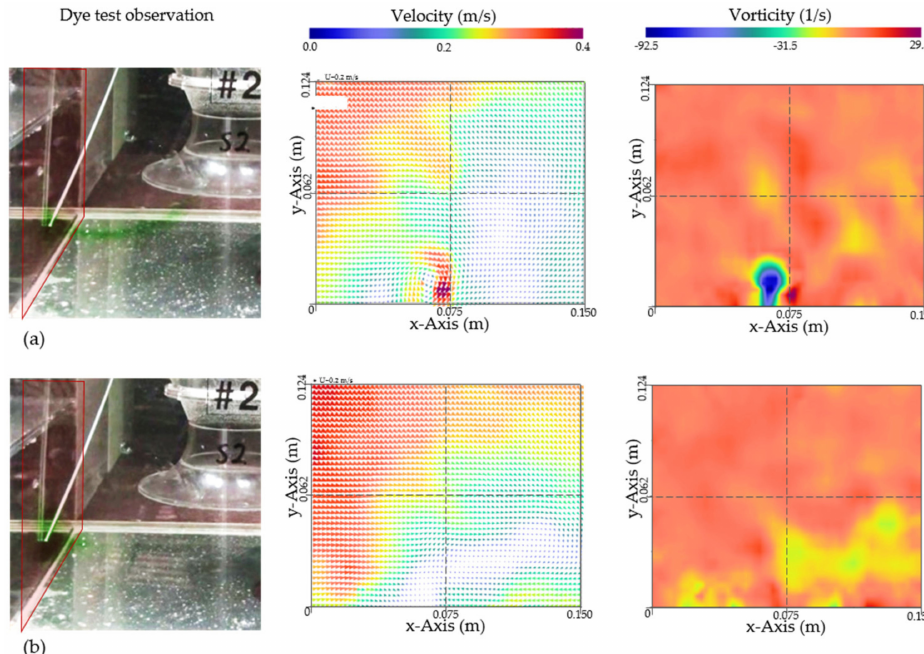
Figure 5. Mapping of dye test results with post-processed PIV results: ( a ) presence of subsurface vortices of Type 2; ( b ) absence of subsurface vortices of Type 2.